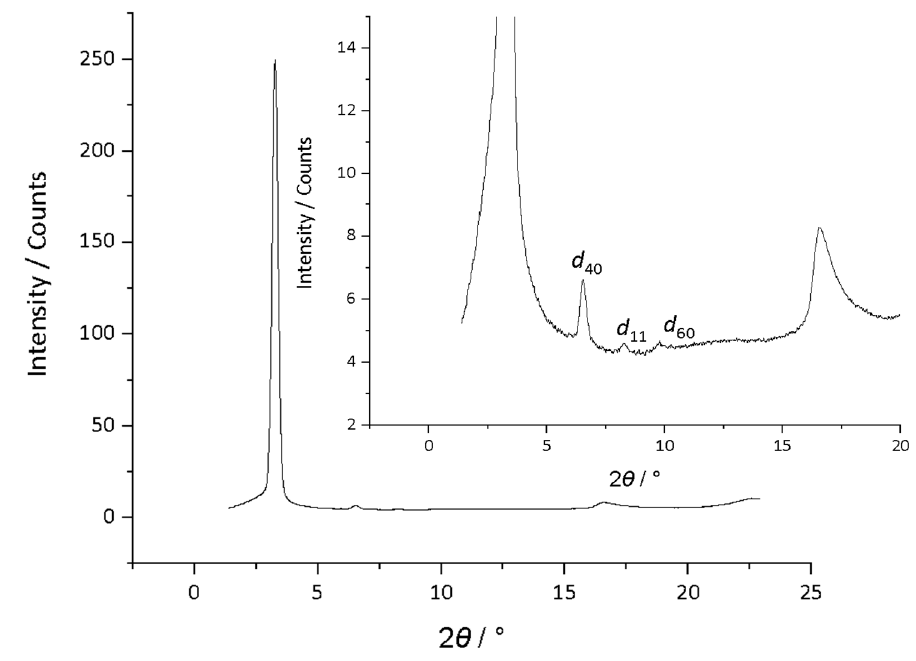
Figure 9. Diffraction pattern of compound 5 -10 at 139 °C: insert represents the zoomed in region for clarity of the low intensity reflections.